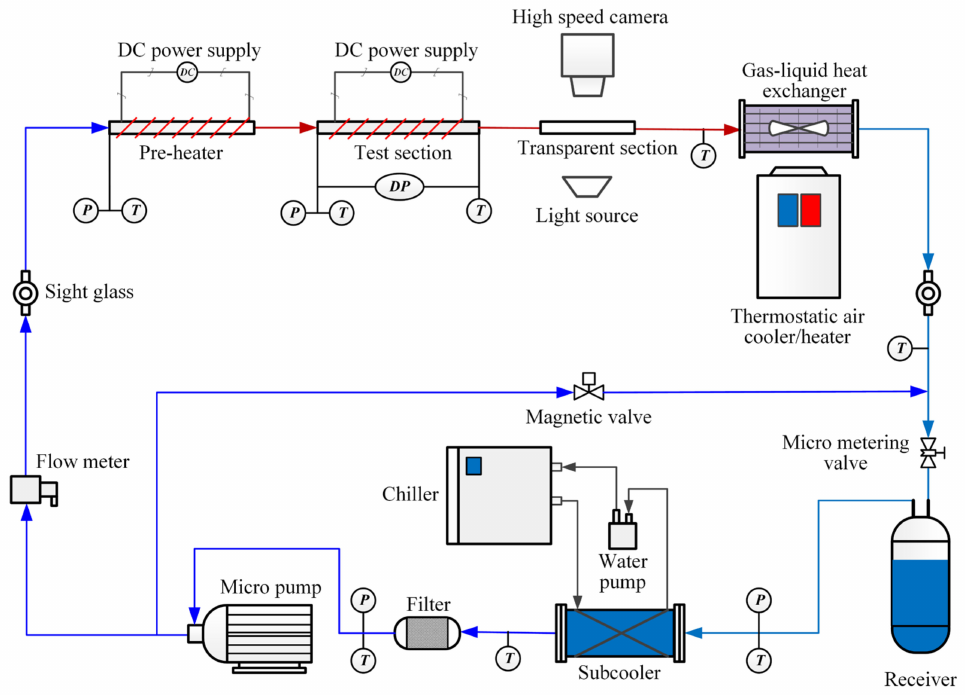
Figure 1. Experimental system: schematic diagram.